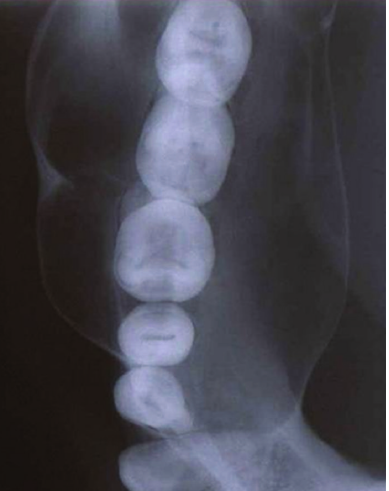
Figure 2: Intraoral photograph, showing slight lingual cortical expansion in the right-side mandibular.